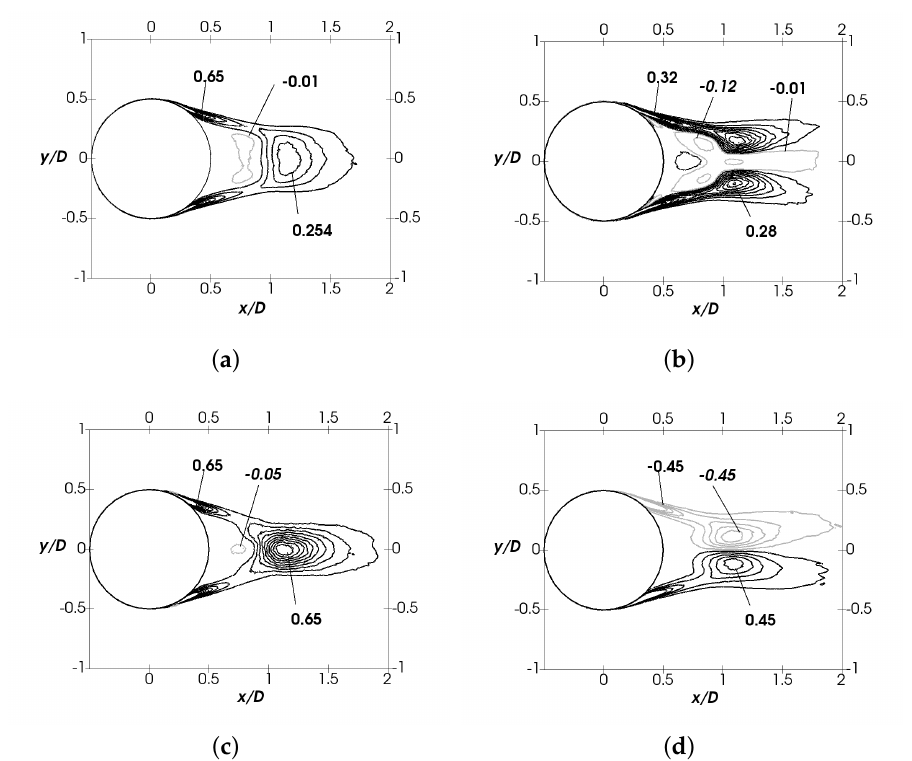
Figure 9. ( a ) Mean turbulent kinetic energy production P k . ( b – d ) Production for the normal and shear stresses (cid:104) u (cid:48)